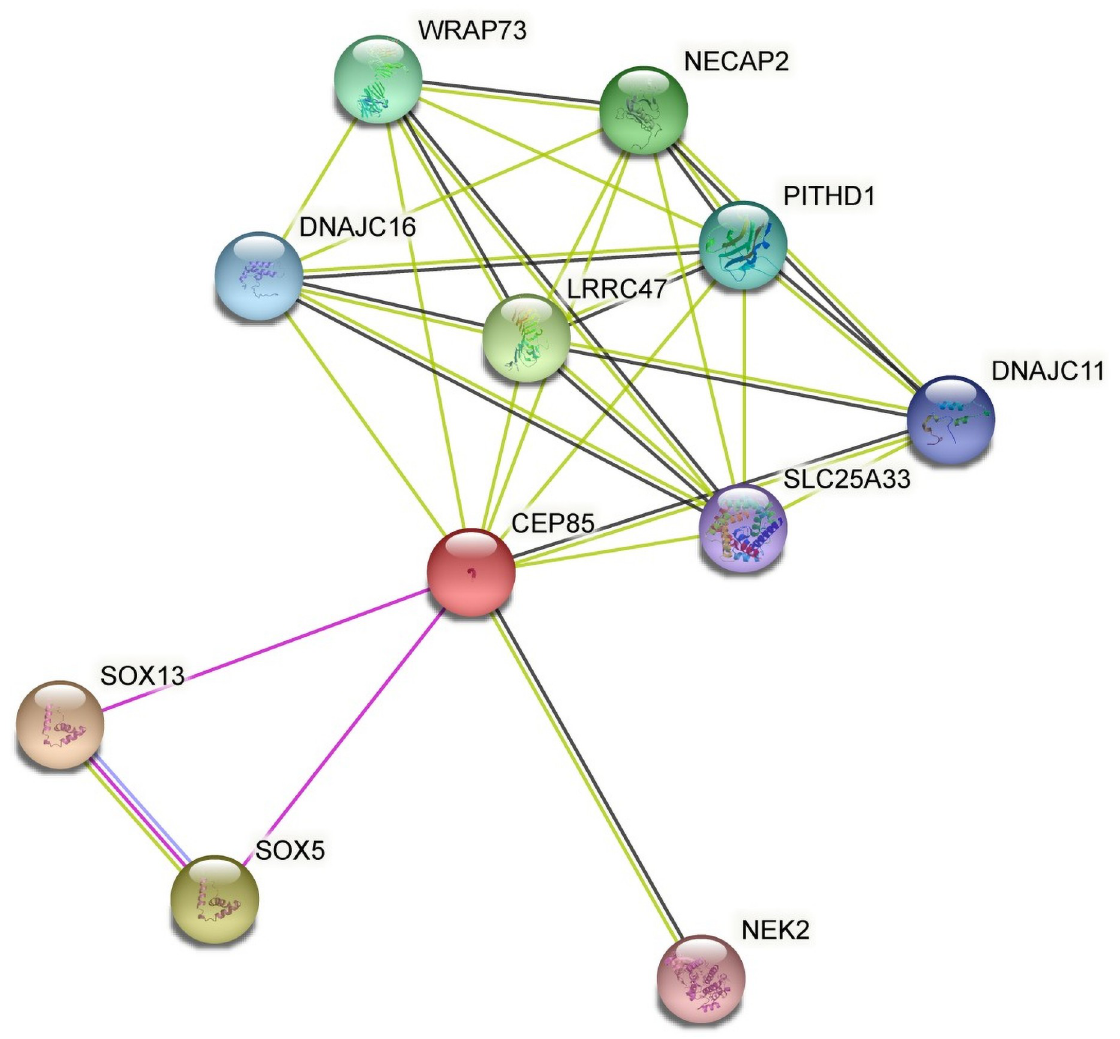
Fig 5. Protein-protein interaction network of Cep85 . Green lines correspond to predicted associations, blue lines to associations reported in other databases, pink lines to experimentally confirmed associations, and black lines to co-expression links. Nodes are colored according to whether they correspond to direct associations (any color), or indirect associations (un-colored, no such association in this case).